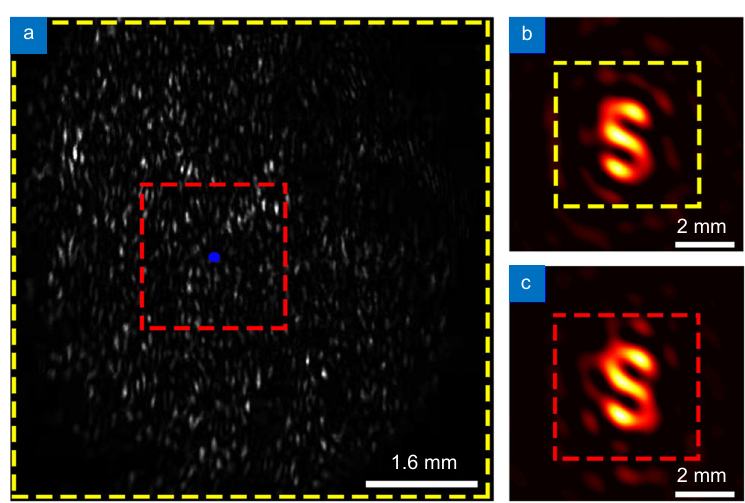
Fig. 8 | ( a ) A typical instantaneous intensity captured by the CCD. ( b ) Experimental results of the recovered image through the area surrounded by the yellow dashed square shown in subplot (a) covering 1440×1440 pixels. ( c ) The recovered image through the area surrounded by the red dashed square shown in subplot (a) covering 500×500